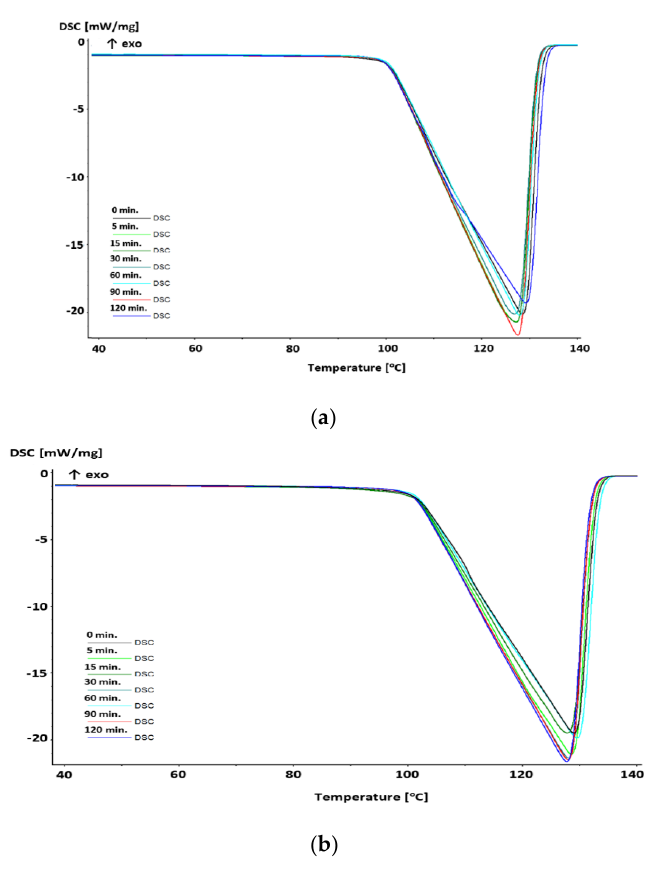
Figure 8. Differential scanning calorimetry (DSC) diagrams for deionized water treated with LPGP for 0–120 min. ( a ) Diagrams for water saturated with molecular oxygen the treated with LPGP (WST); ( b ) diagrams for water treated with LPGP then saturated with molecular oxygen (WTS) .